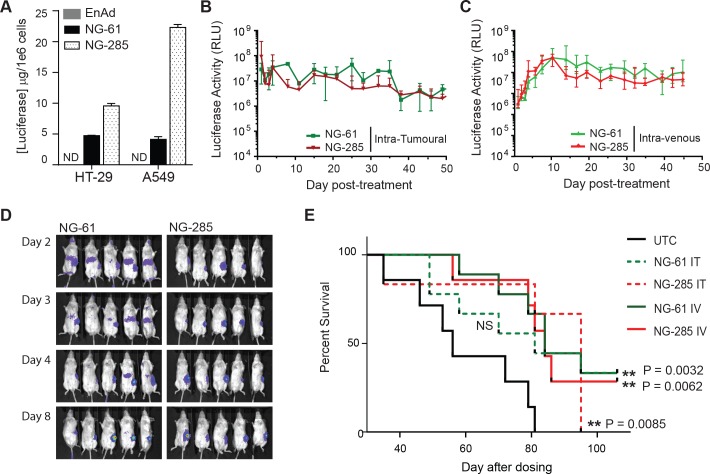
Characterisation of transgene expression, virus activity and virus efficacy in vivo using luciferase reporter viruses.(A) Quantification of luciferase expression (μg/1x106 cells) in HT-29 and A549 cells infected with 10 ppc enadenotucirev, NG-61 or NG-285 virus particles for 24-48hrs. (B) Measurement of luciferase activity by imaging A549 lung carcinoma sub-cutaneous xenograft tumours treated IT at Day 0 with either 5x109 NG-61 or NG-285 virus particles. (C) Measurement of luciferase activity by imaging A549 lung carcinoma sub-cutaneous xenograft tumours treated IV at Day 0 with either 5x109 NG-61 or NG-285 virus particles. Graphs shows light units detected at each time point relative to untreated controls, data is plotted as relative light units (RLU) median ± interquartile range for n = 5 mice per treatment group. (D) Images showing detection of luciferase expression in mice bearing A549 subcutaneous xenograft tumours (as in (C)) treated IV with 5x109 NG-61 (left panels) or NG-285 (right panels) virus particles. Luciferase expression could be observed in flank tumours in all treated mice and in the livers of NG-61 treated mice (left panel, Day 2–4). (E) Kaplan-Meier plot showing percent survival, assessed by measurement of tumour burden, for mice imaged in B-D that were bearing A549 subcutaneous xenograft tumours treated with 5x109 NG-61 or NG-285 virus particles delivered by single IT or single IV injection at Day 0 (n = 10 mice per treatment group, **P<0.005 Log rank test).